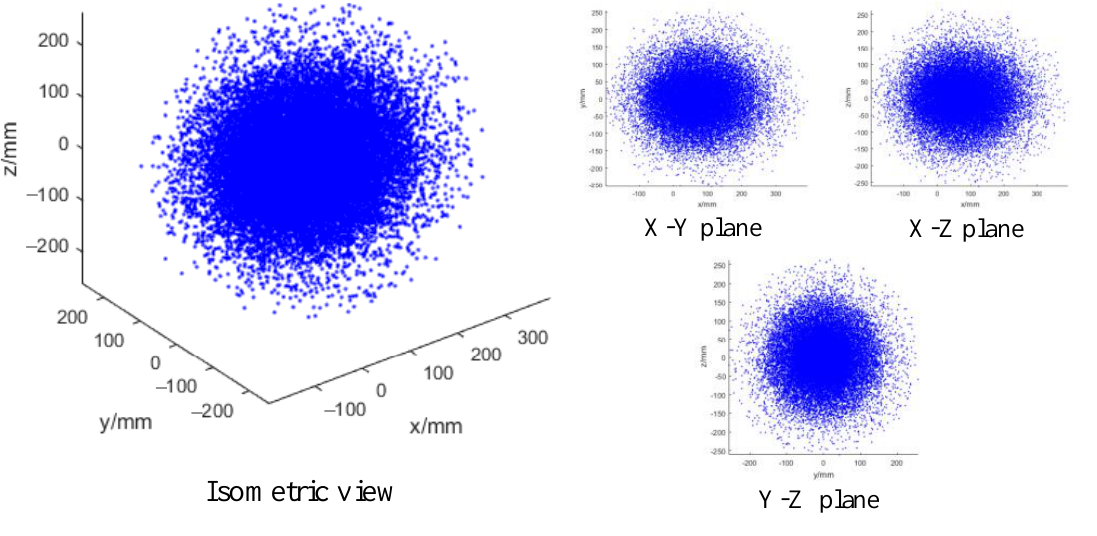
Figure 9. Working space of the single arm.